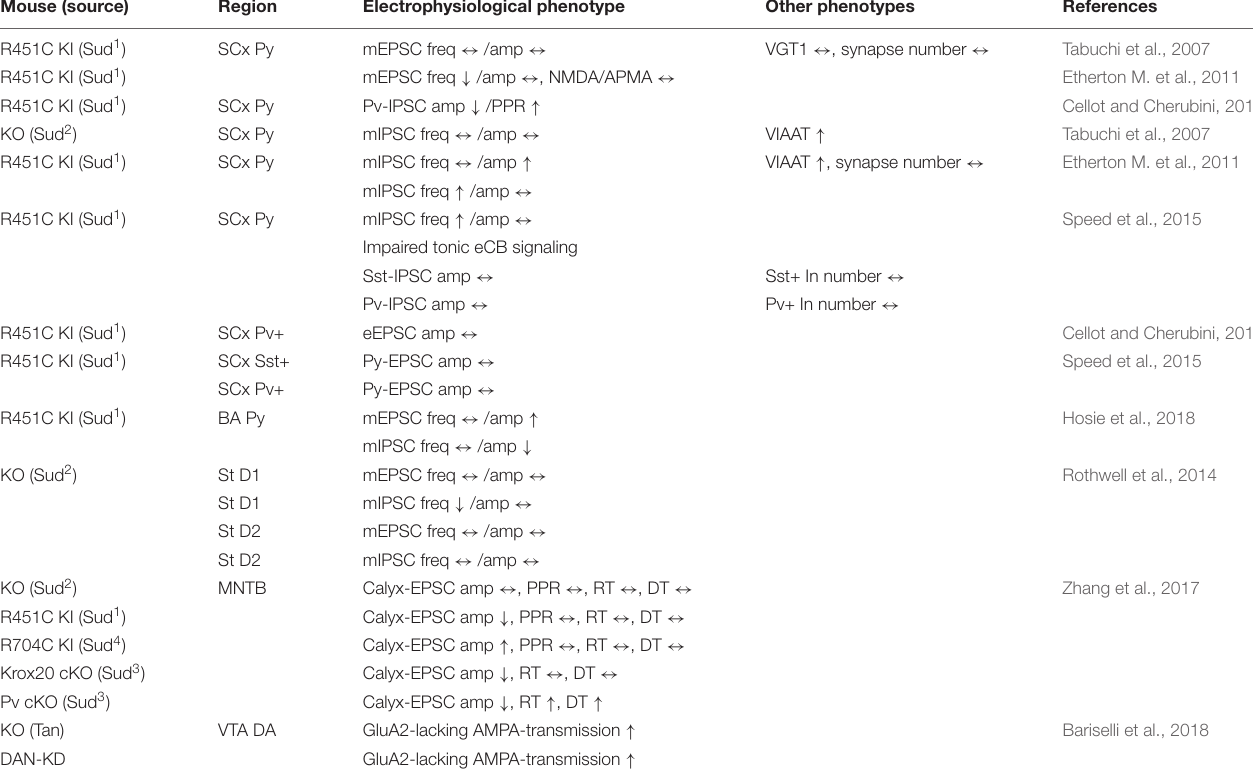
TABLE 2 | Summary of electrophysiological and other phenotypes in Nlgn3 mutant mouse lines in other brain regions. Mouse